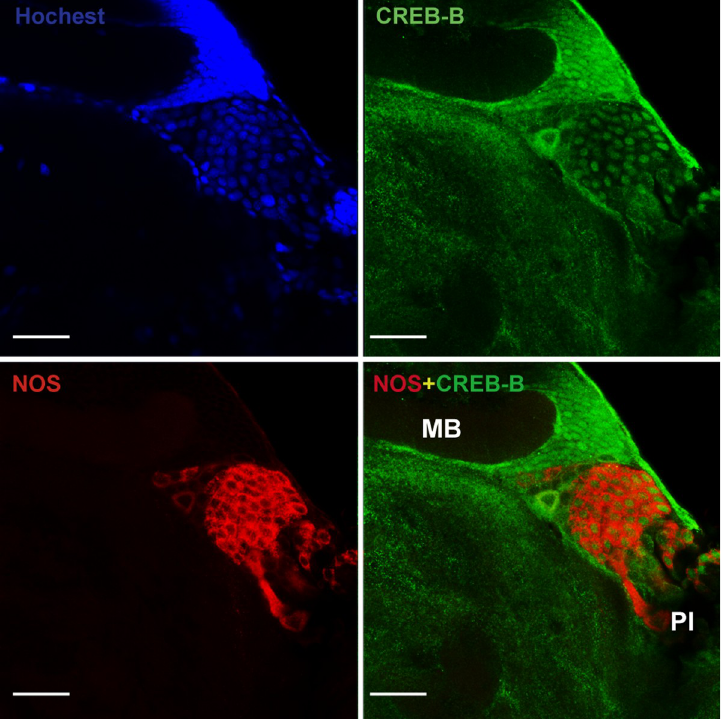
Fig 3. Subcellular localization of CREB-B and NOS in the pars intercerebralis (PI) of locust brain. Both CREB-B and NOS expressed in the neurons of PI. CREB-B mainly localized in the nuclei. Polyclonal antibody against p(S133)- CREB1 (1:100) and uNOS (1:100) were used in the immunohistochemistry assay. Green indicates CREB-B staining, red indicates NOS staining. Bar represents 100 μ m.